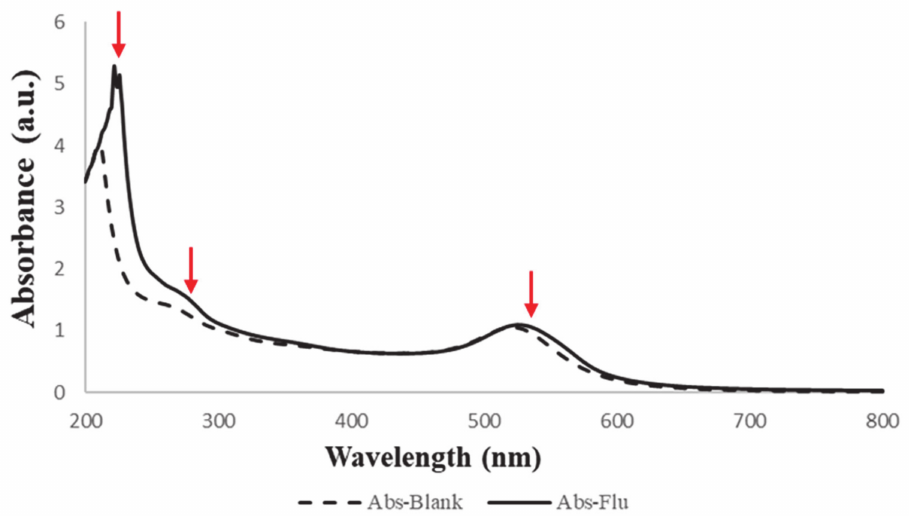
Figure 7. UV–Vis absorbance spectra of SA-Au NPs after been immersed with a positive influenza swab (Abs-Flu) compared to a negative blank swab (Abs-Blank) that show a slight broadness of the SPR band at 525 nm, a broadness at ≈ 277 nm and the formation of an intense peak at 222 nm that was originally at 214